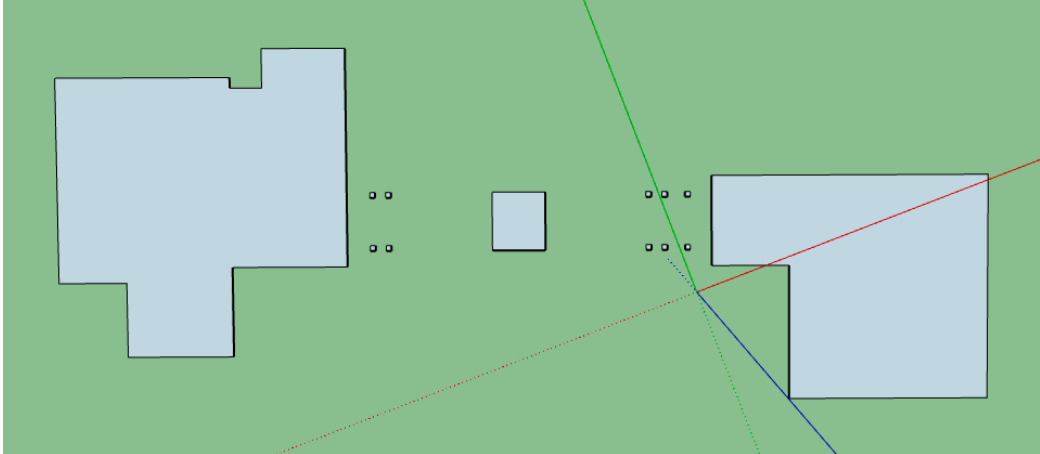
Figure 4. Building footprint based on aerial photos and Google Earth.